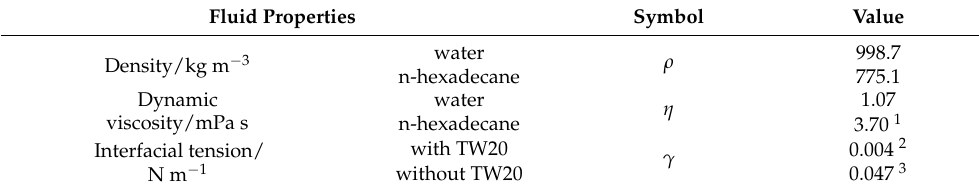
Table A1. Fluid properties at ϑ exp = 17.5 ◦ C used for the calculations of the dimensionless numbers.